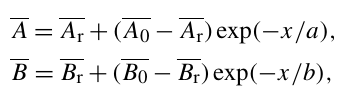
Table 1. Dimensionless parameters adopted in the analytical model for tide–river